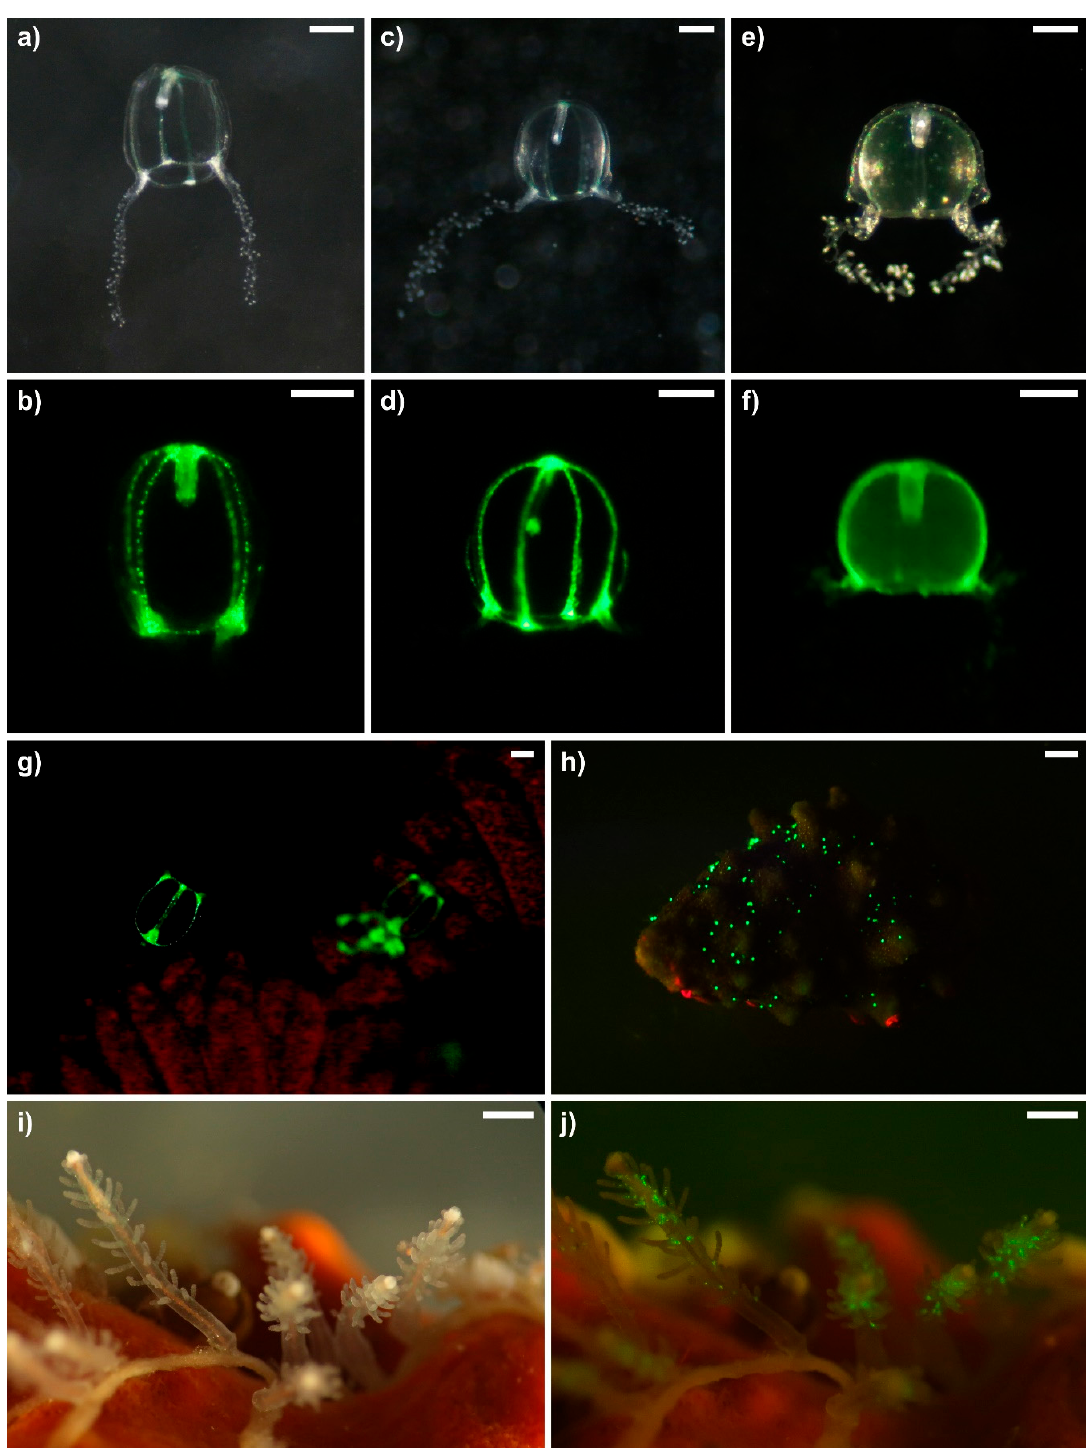
Figure 8. Green fluorescence in Zanclea and Asyncoryne species. ( a,b ) Medusa of Zanclea sp. (Clade I) released from a colony associated with Goniastrea sp.; ( c,d ) medusa of Zanclea sango; ( e,f ) medusa of Zanclea protecta ; ( g ) medusa of Zanclea sp. before release, associated with Goniastrea sp.; ( h ) Zanclea cf. protecta medusa buds in the colony associated with Schizoporella sp. overgrowing the gastropod Drupella sp.; ( i,j ) Asyncoryne ryniensis polyps. Scale bars: ( a–g ) 0.2 mm; ( h ) 5 mm; ( i,j ) 1 mm.